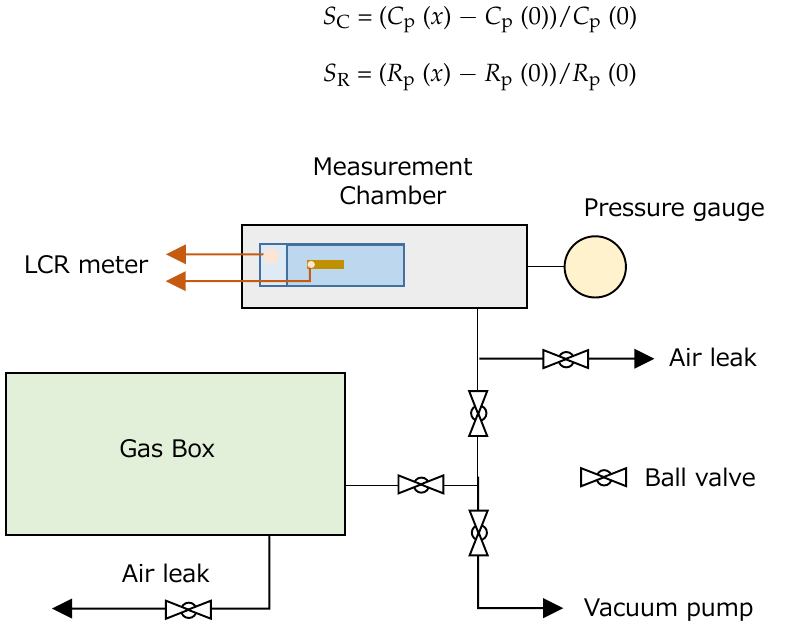
Figure 2. Schematic illustration of the measurement configuration for evaluating the humidity sensitivity of the sample device.